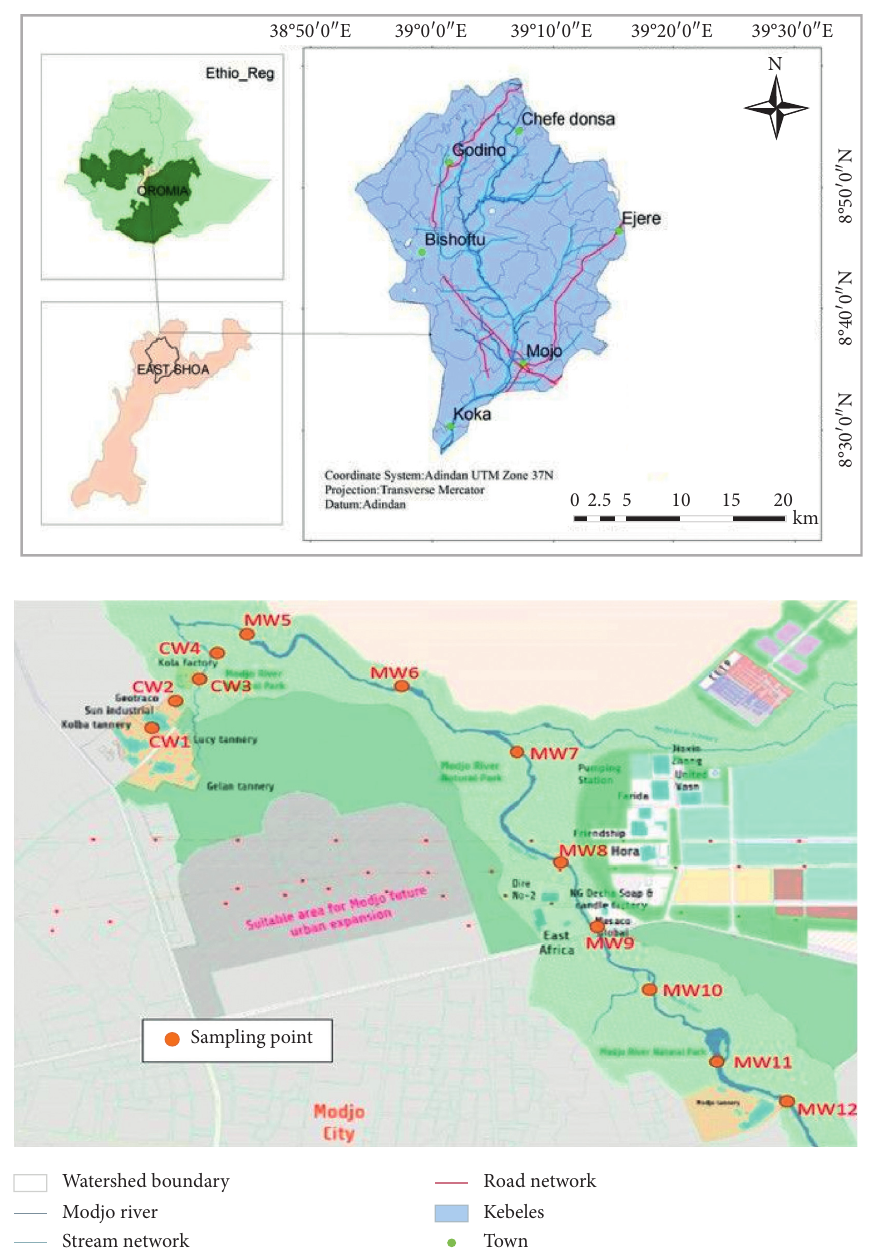
Figure 1: Location of the study area, Modjo, Ethiopia (CW � Colba tannery wastewater; MW � Modjo River water) (Source: United Nations Industrial Development Organization,